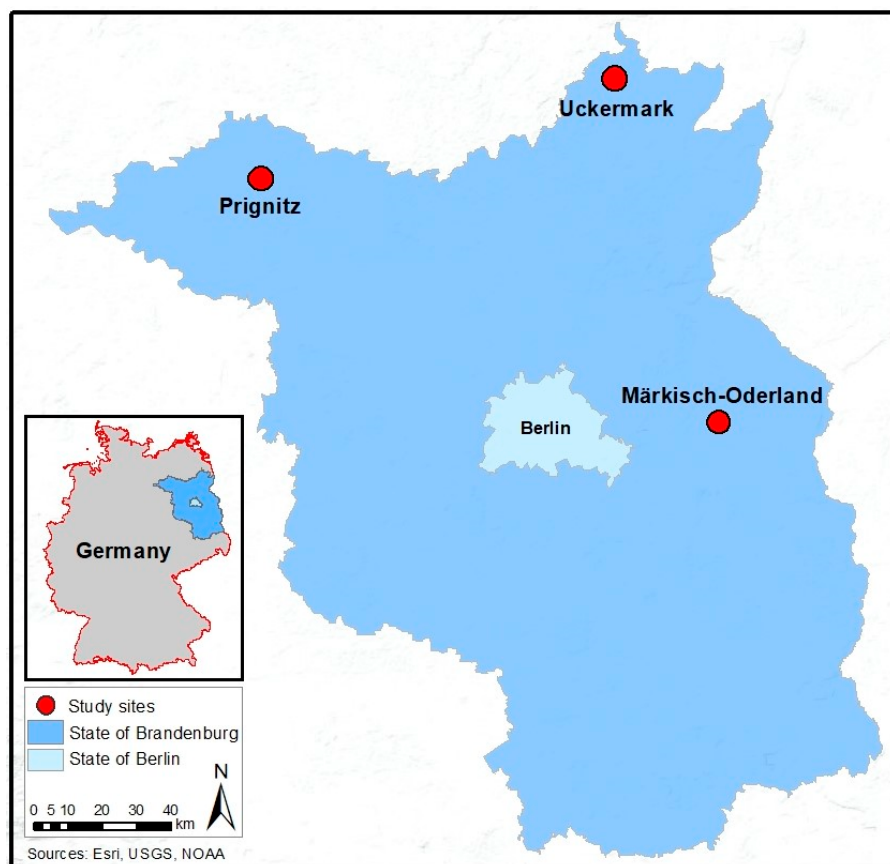
Figure 1. Location of the three study sites within in the Uckermark, Märkisch-Oderland, and Prignitz regions of the German federal state of Brandenburg.